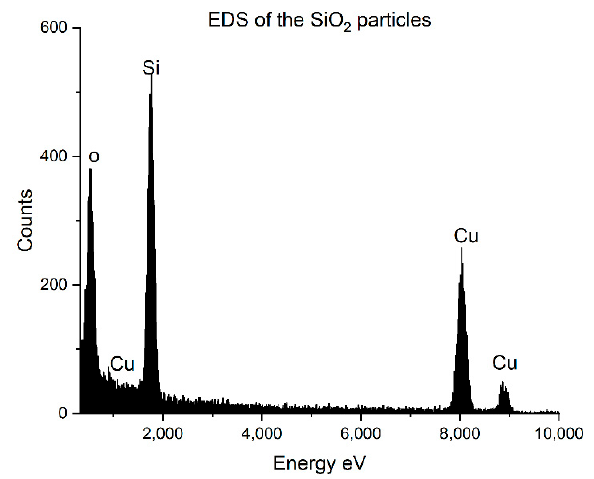
Figure 3. EDS of the SiO 2 particles.